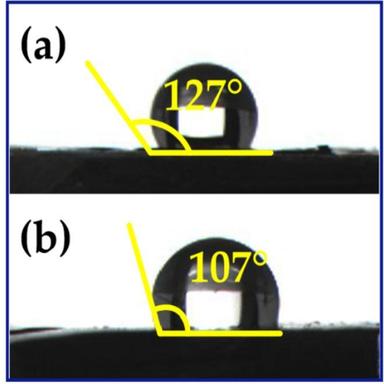
The contact angle results of CNF (a) and CNFeN9 (b).